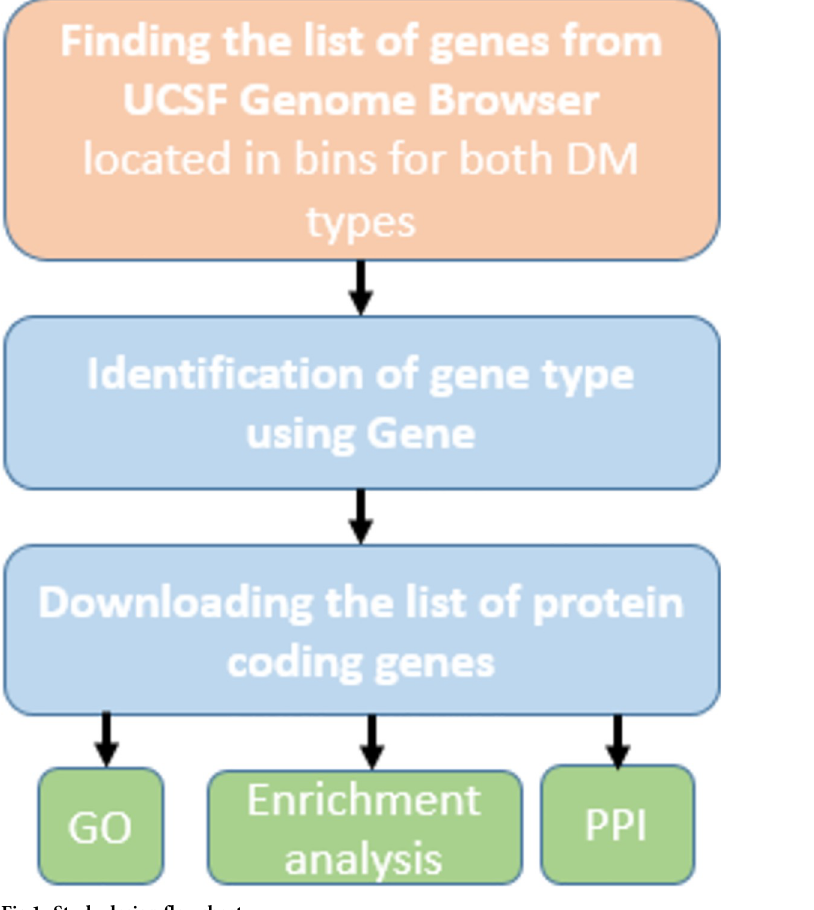
Fig 1. Study design